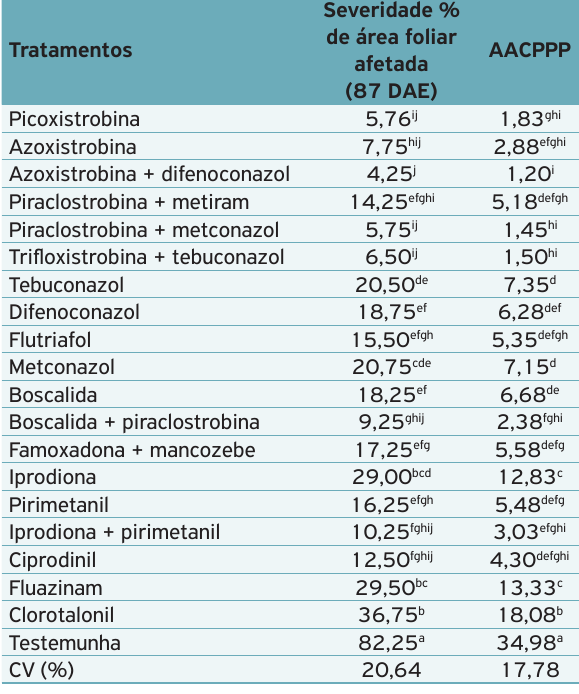
Tabela 3. Severidade e área abaixo da curva de progresso da pinta preta obtida em plantas de batata (cultivar Monalisa) tratadas